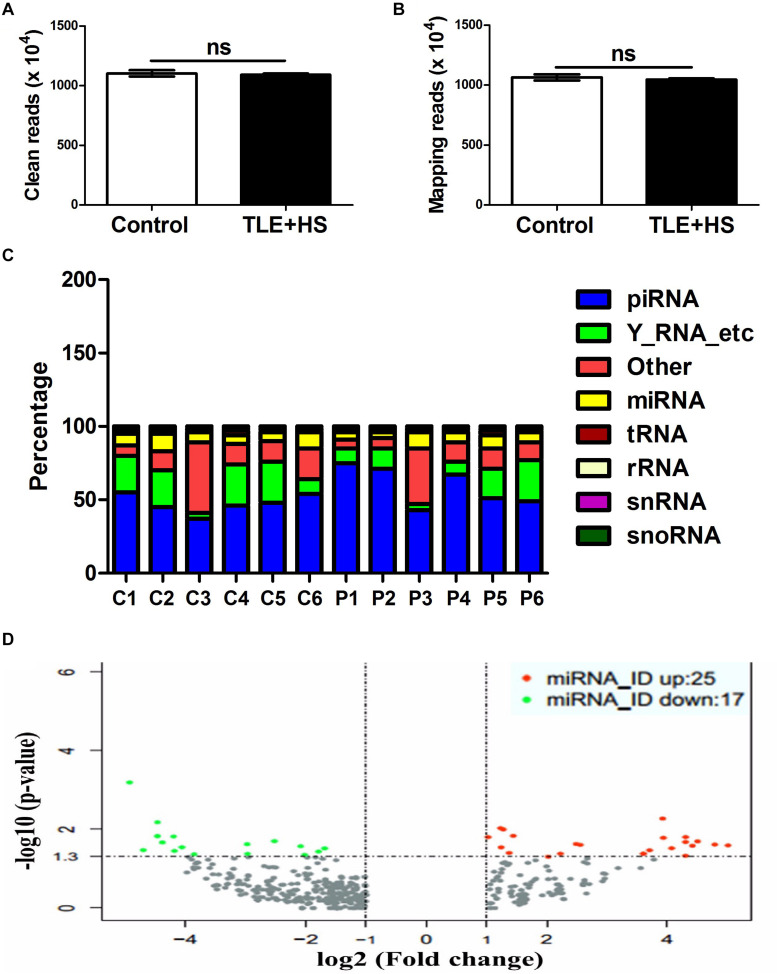
The circulating signatures of the exosome-derived miRNAs identified by HiSeq 2500 sequencing. The clean read numbers (A, p = 0.66) and mapping read numbers (B, p = 0.52) identified in the six mTLE–HS controls and six mTLE + HS patients. (C) The distribution of the mappable small RNAs detected by sequencing of the six mTLE–HS controls and six mTLE + HS samples. (piRNA, piwi-interacting RNA; Y-RNA-etc, Ro RNP; other, miscellaneous other RNA; miRNA, microRNA; tRNA, transfer RNA; rRNA, ribosomal RNA; snRNA, small nuclear RNA; snoRNA, small nucleolar RNA; P, patient; C, control.) (D) The volcano plot showing the relationship between the logarithm of the p-value on the y-axis and the log2 (fold-change) between the patients and controls on the x-axis. The vertical line marks the border between the results for the patients and those of the controls. Red indicates miRNAs with expression changes twofold greater than that of the remaining miRNAs, while green indicates miRNAs with expression changes less than 0.5-fold than that of the remaining miRNAs. (bar, SD.)